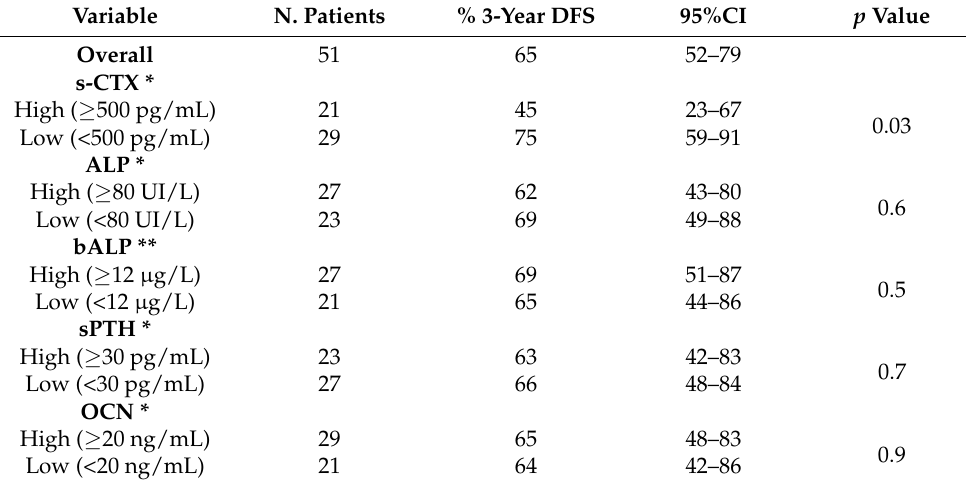
Table 3. Disease-free survival (DFS) in patients with GCT of bone according to baseline serum levels of carboxyterminal-crosslinked-telopeptide of type I collagen (s-CTX), alkaline phosphatase (ALP), bone-alkaline phosphatase (bALP), parathyroid hormone (sPTH), and osteocalcin (OCN). * missing in 1 patient; ** missing in 3